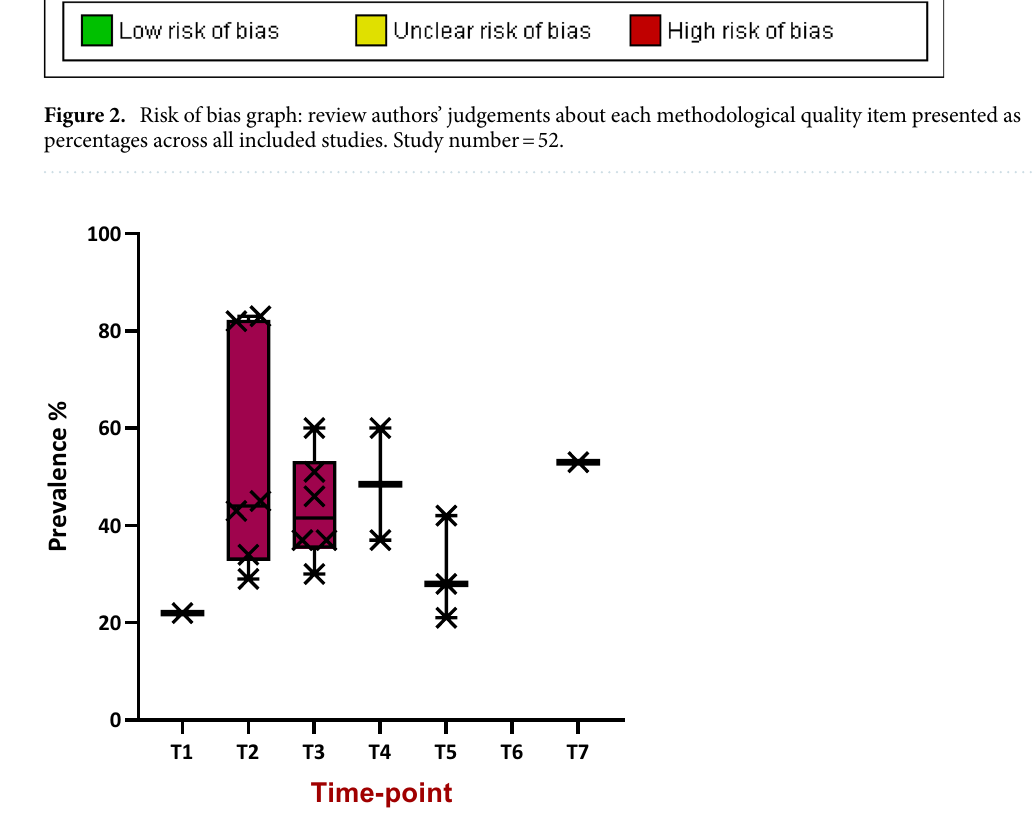
Figure 3. Boxplot of prevalence reported for cognitive impairment, via self-report methods, across the time- points included in the review (data from 12 studies in Tables 1, 3 studies were excluded due to mixed or unclear timing of assessment 54,55,58